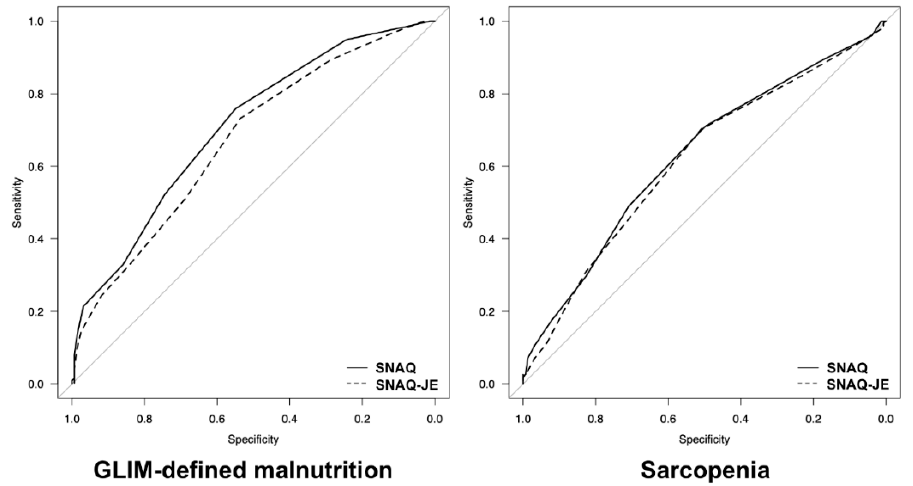
Figure 1. Comparison of the receiver-operating characteristic curves of the SNAQ and SNAQ-JE for GLIM-defined malnutrition and sarcopenia. Abbreviations: SNAQ: Simplified Nutritional